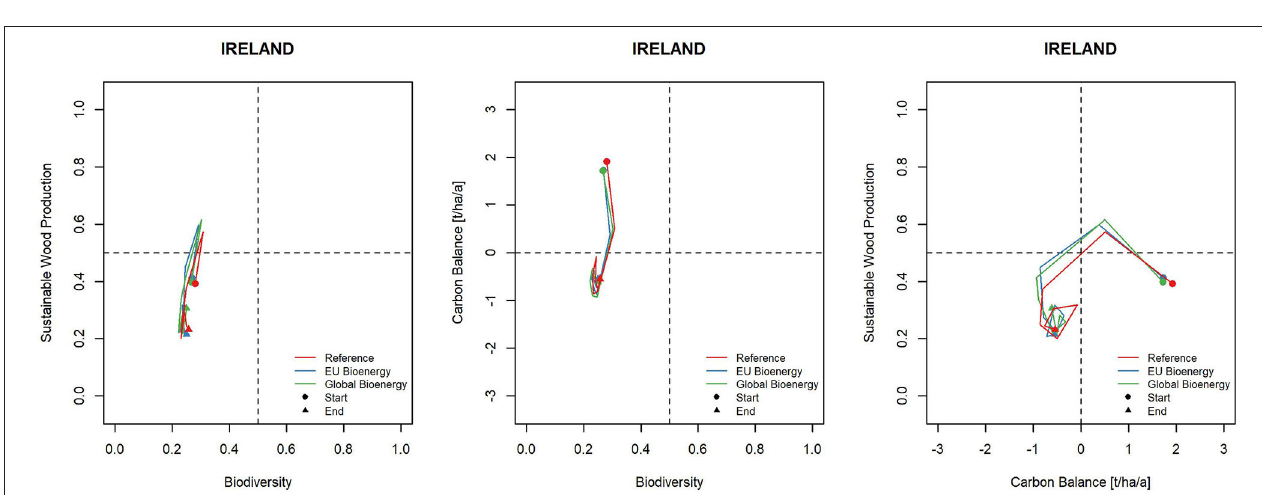
FIGURE 4 | Trade-off diagrams for